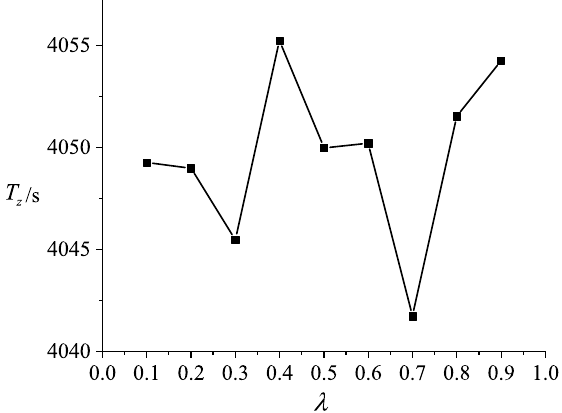
Figure 15. Total time T z varying with membership evaluation λ .